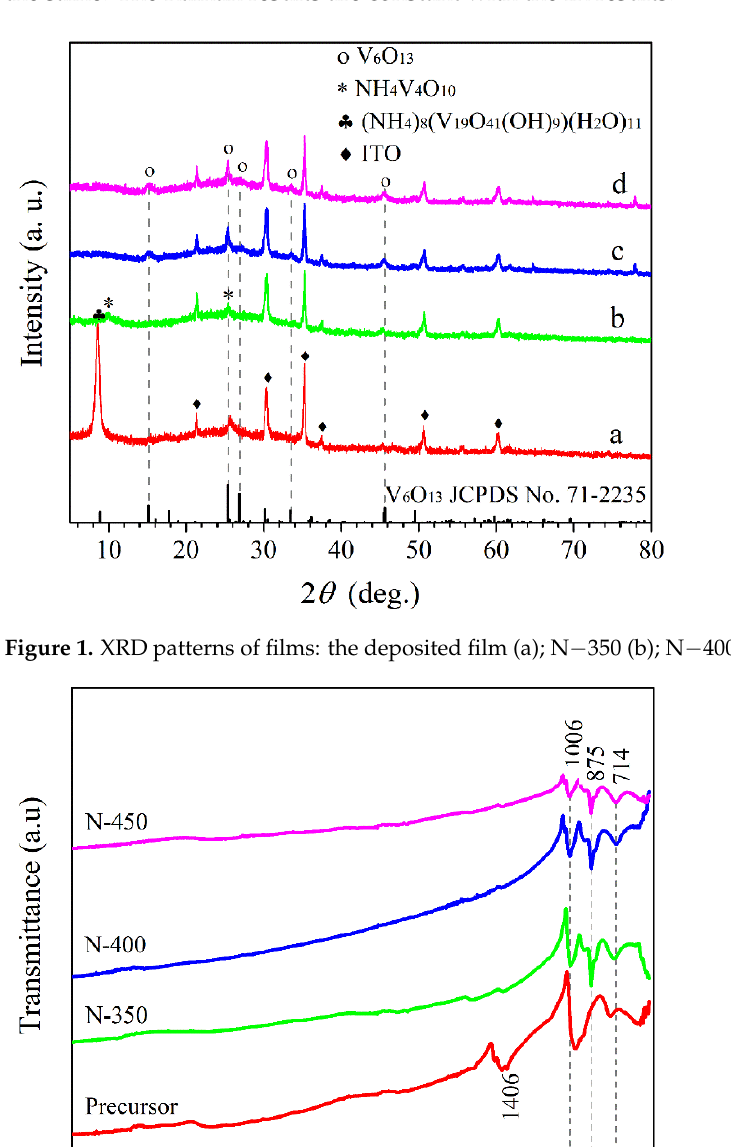
Figure 1. XRD patterns of films: the deposited film (a); N − 350 (b); N − 400 (c); N − 450 (d).